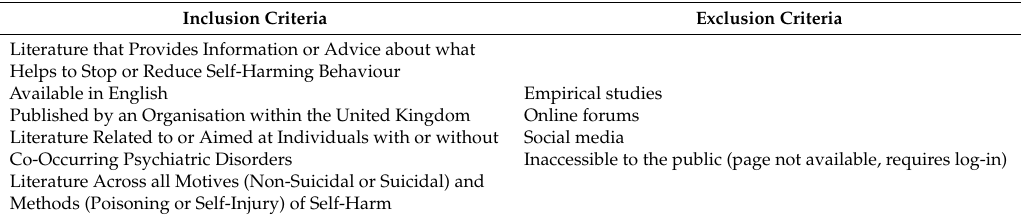
Table 1. Grey literature review eligibility